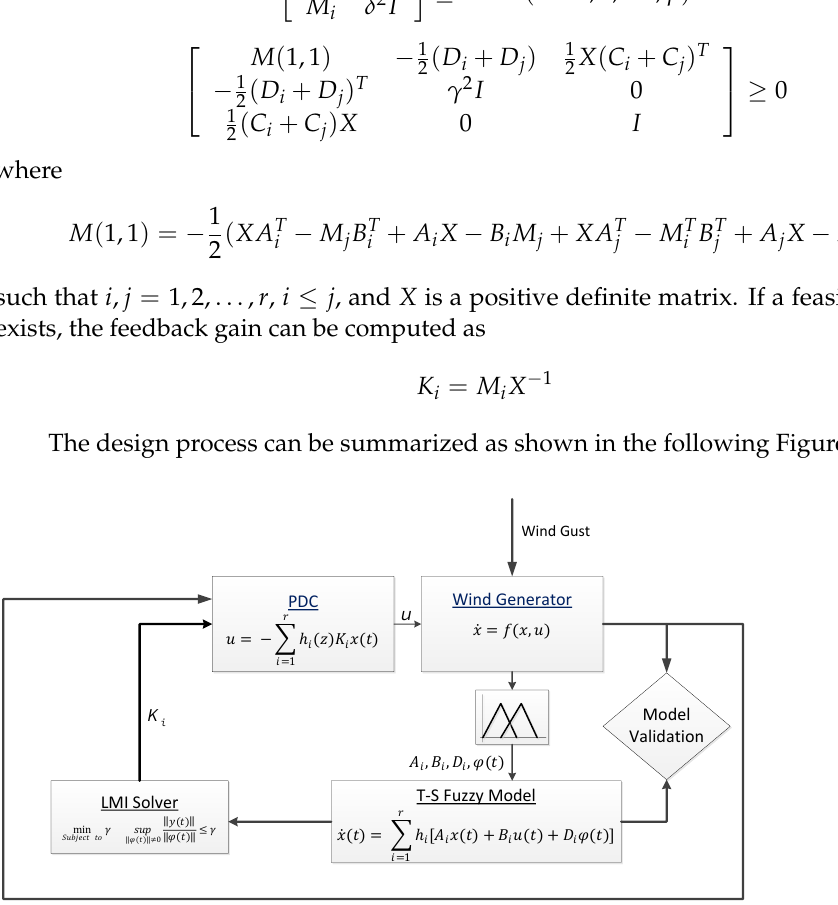
Figure 2. Flowchart of the design and controller